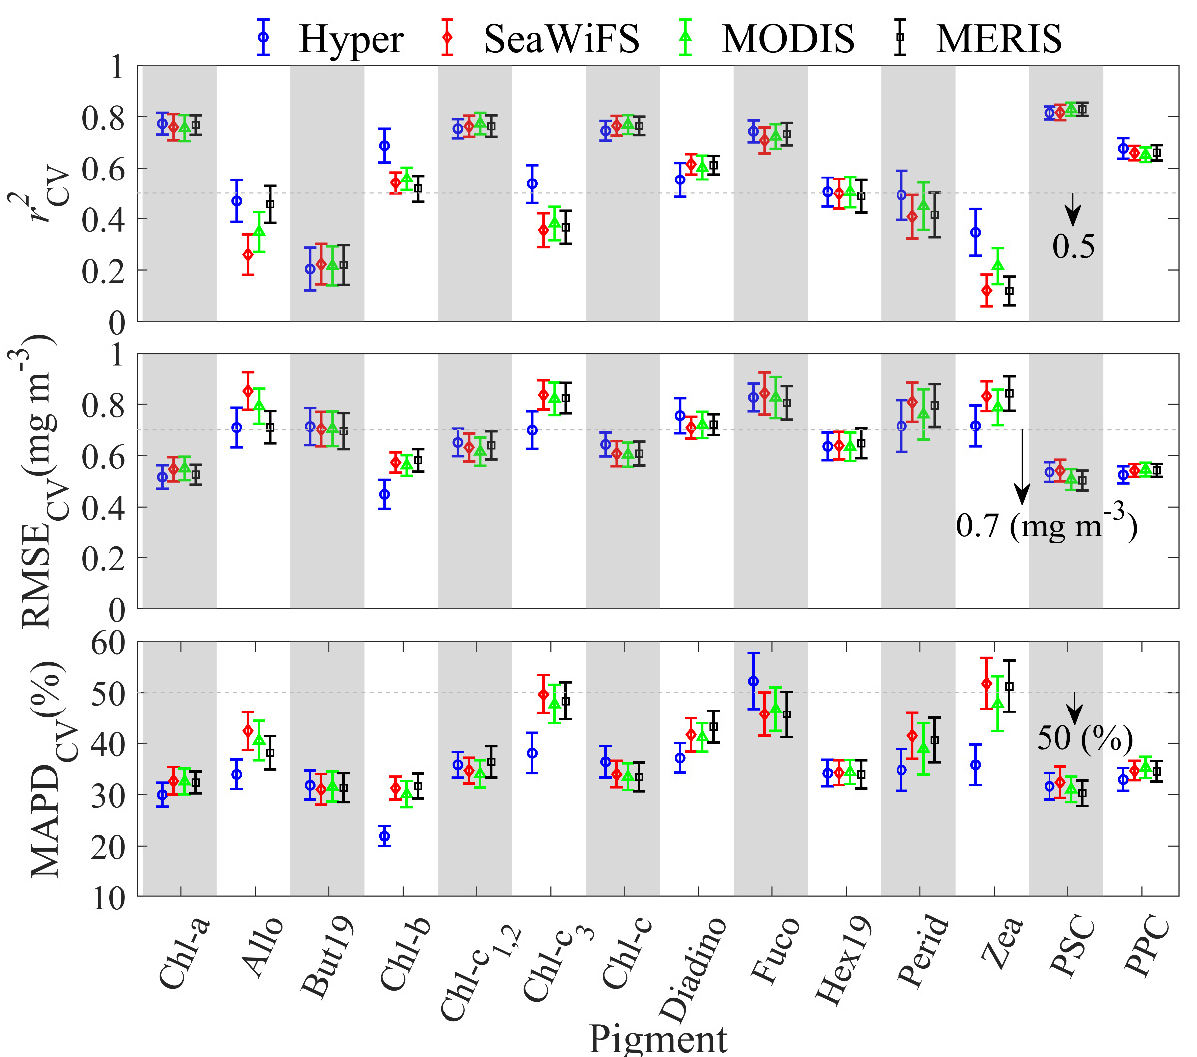
Figure 8. Cross validation (CV) statistics ( r 2 CV , RMSE CV , and MAPD CV ) between observed pigment concentrations and modeled pigment concentrations produced by the PLS model using hyperspectral a B ( λ ) , Multi_SeaWiFS, Multi_MODIS, and Multi_MERIS.